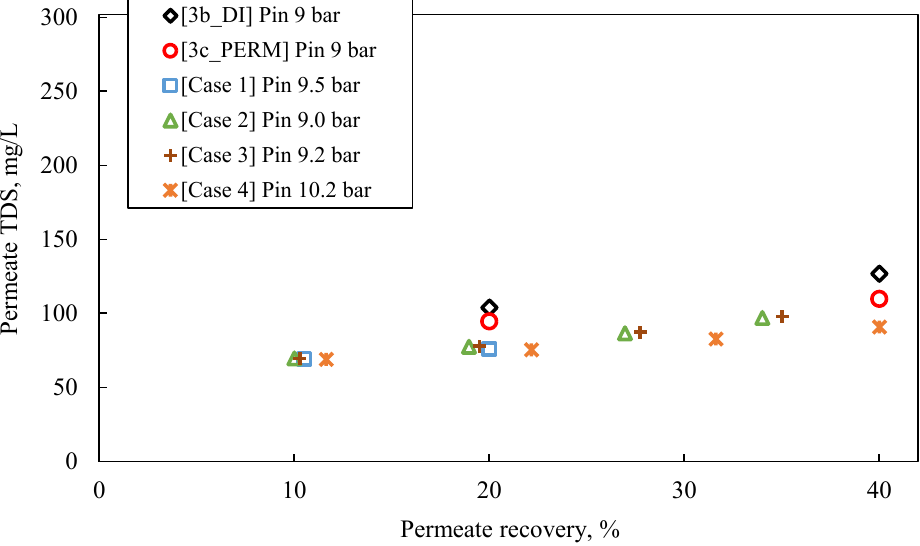
Figure 9. Experimental data (tests #3b_DI and #3c_PERM) on variation of permeate quality in terms of TDS, compared with results obtained from SWM simulator (Cases 1–4); Feed: S5.